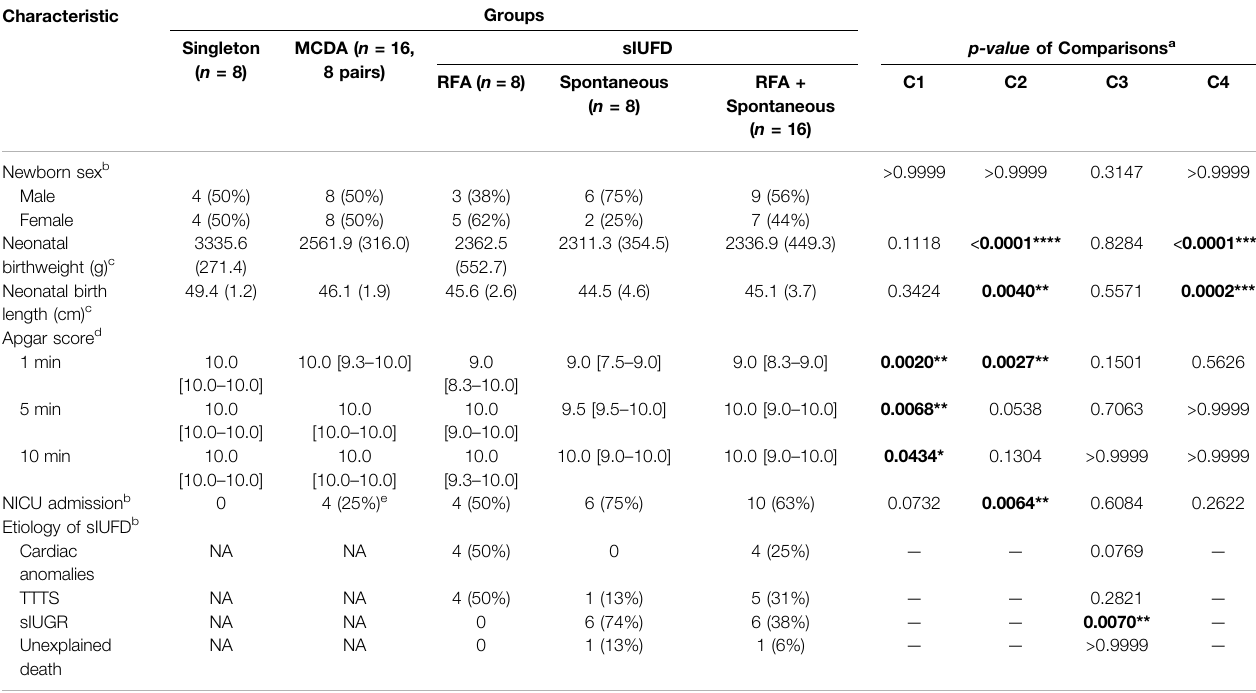
TABLE 2 | Demographic and clinical characteristics of